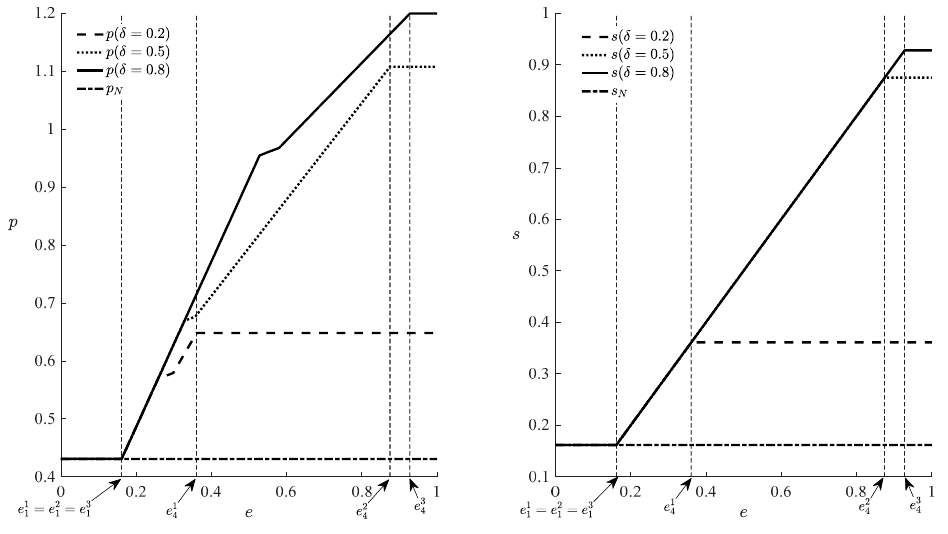
Figure 2. Relationship between p , s , and e